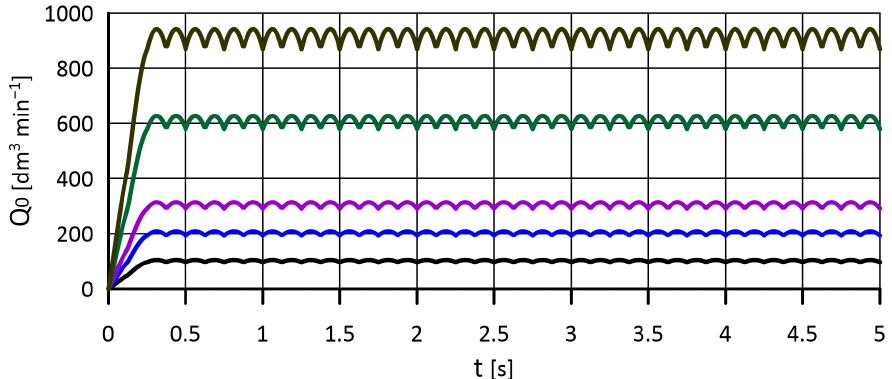
Figure 10. Piston pump flow rate with an average value of: 100 ( 1 ) , 200 ( 2 ) , 300 ( 3 ) , 600 ( 4 ) , and 900 ( 5 ) dm 3 min − 1